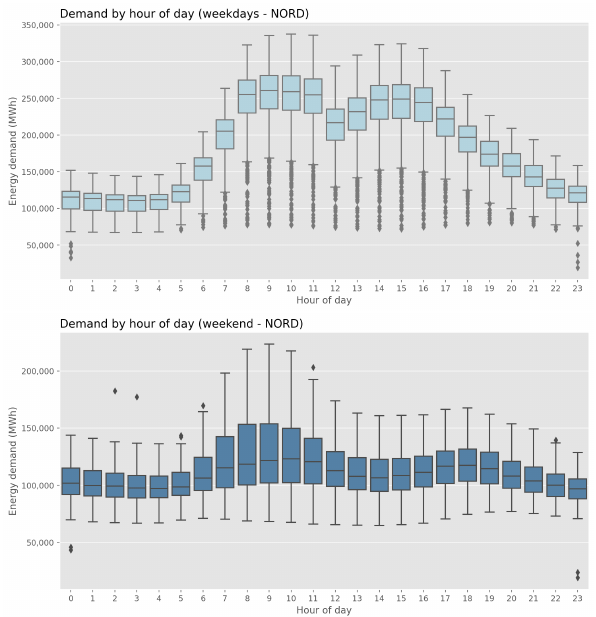
Figure 5. Boxplot of the energy demand by hour of the day for weekdays and weekends in